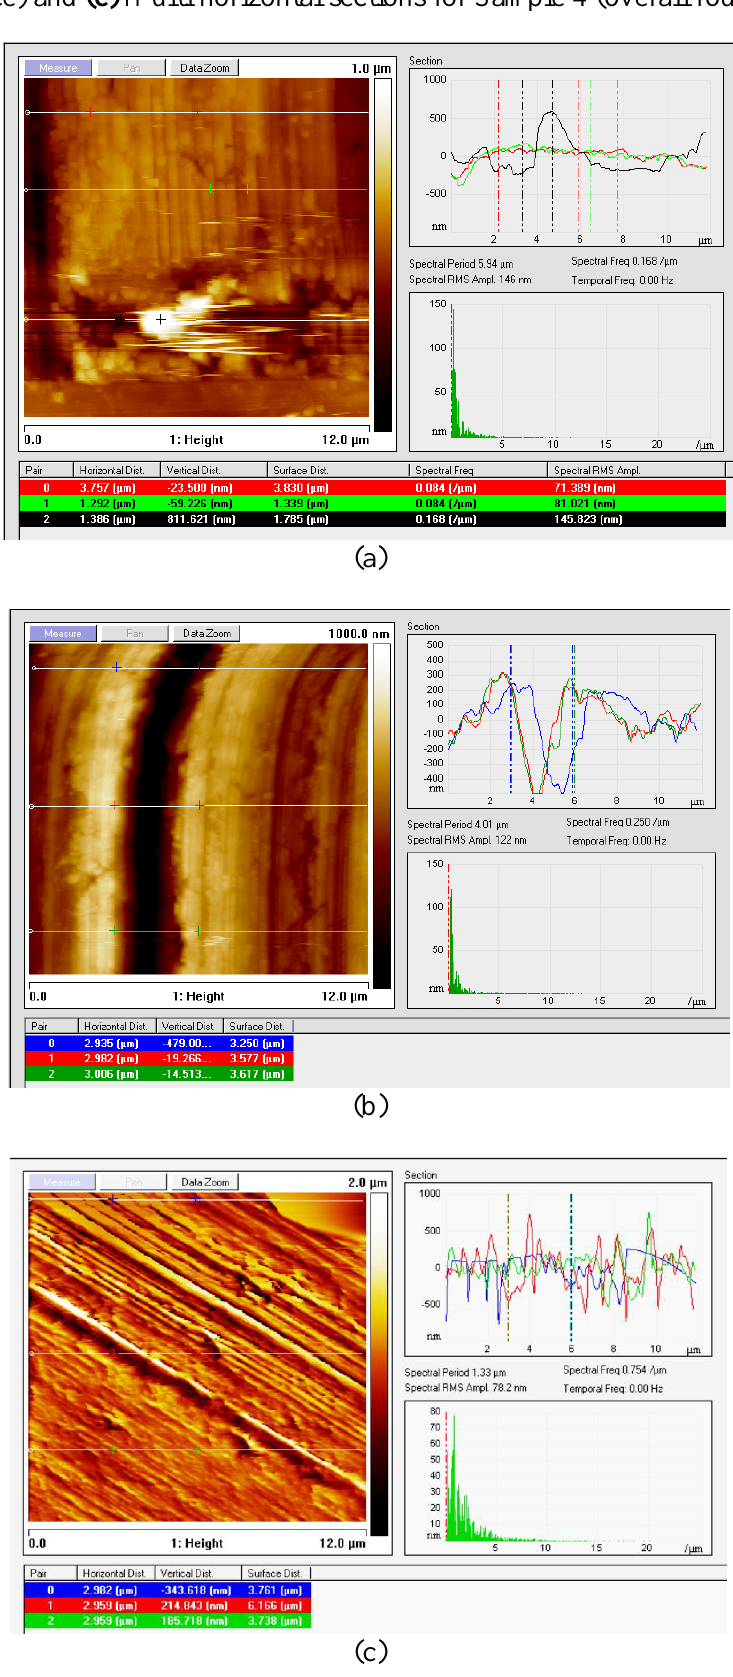
Figure 11. Section surface analysis of K68 uncoated carbide inserts (a) Multi horizontal sections for Sample 1 (partially defected); (b) Multi horizontal sections for Sample 2 (cracked surface) and (c) Multi horizontal sections for Sample 4 (overall rough